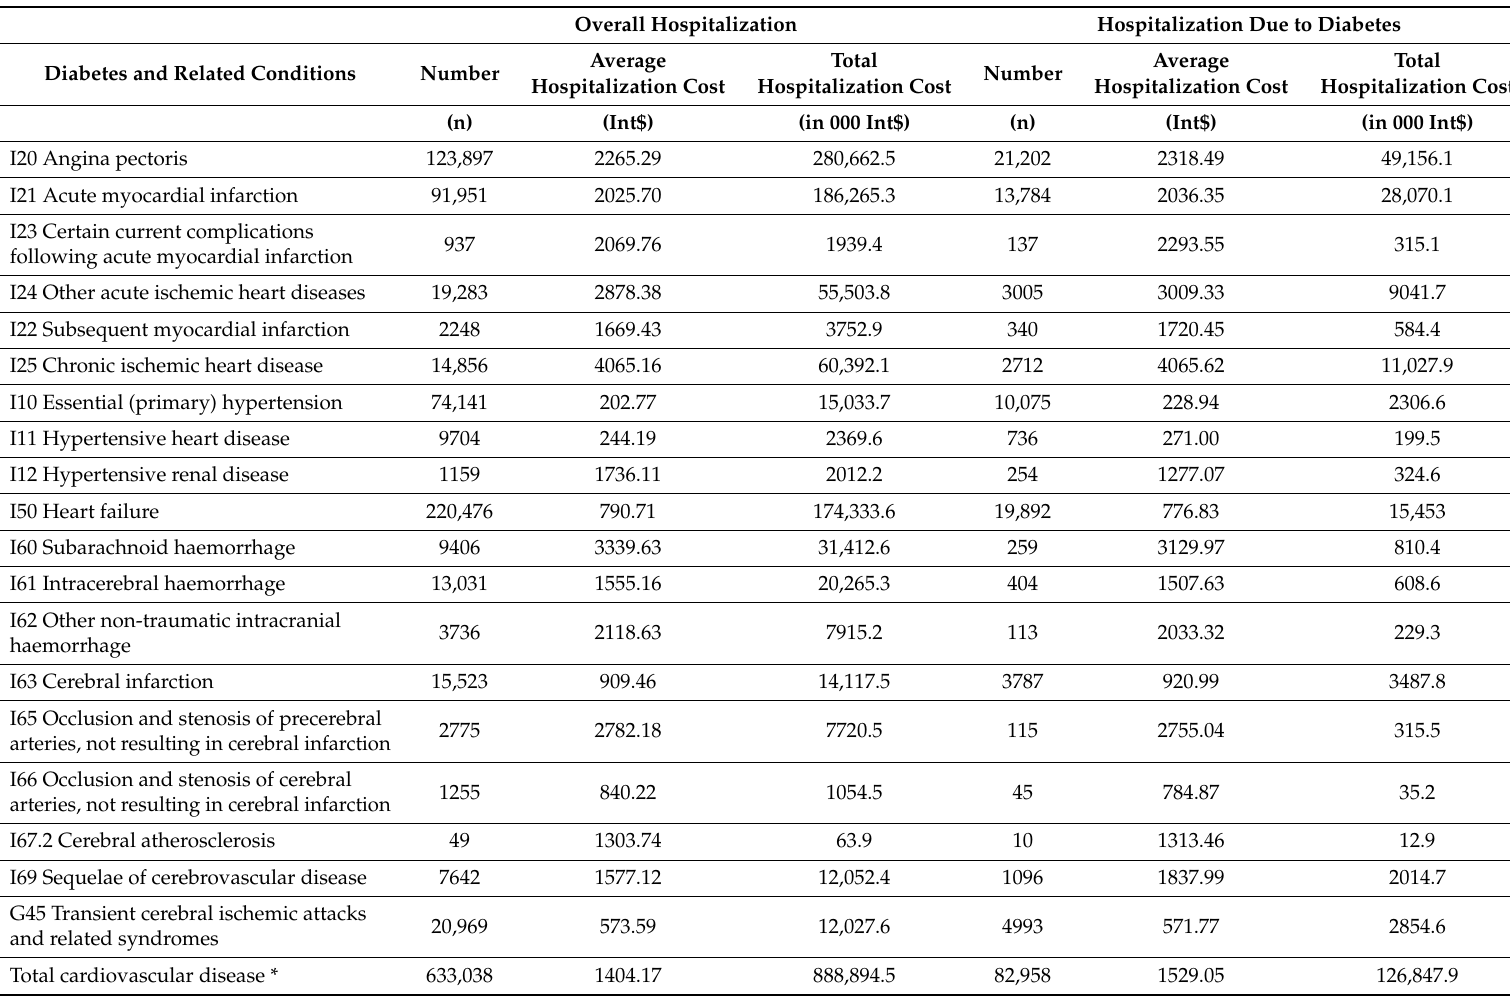
Table 5. Number, average and total hospitalization cost due to cardiovascular disease, overall and related to diabetes, adults (20+ years), SUS, Brazil, 2014. Overall Hospitalization Hospitalization Due to Diabetes Diabetes and Related